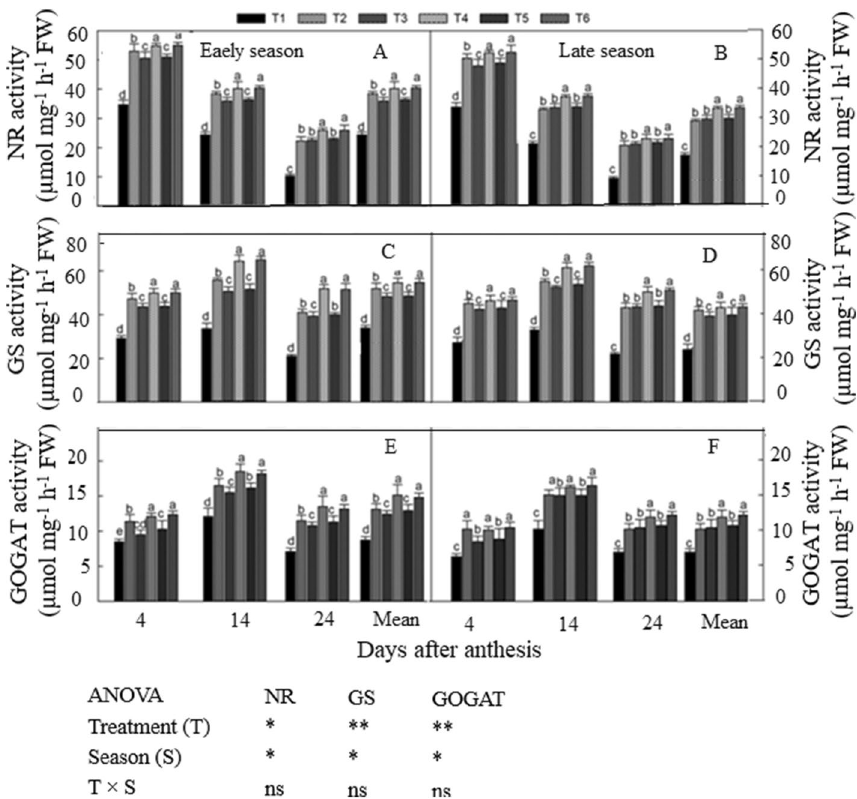
Figure 4. Changes in N metabolism enzyme activities at 4,1 4, and 24 days after anthesis during grain filling period, NR,GS and GOGAT at early season ( A – C – E ) and late season ( B – D – F ) in response to combined organic and inorganic N fertilizer application. Vertical bar represents the standard error of mean. Different letters above the column indicate statistical significance at the ( P < 0.05). Note: NR–nitrate reductase, GS–glutamine synthetase, GOGAT–glutamine oxoglutarate aminotransferase. ns: non significant, * p < 0.05, ** p < 0.05. For treatment details please see Table